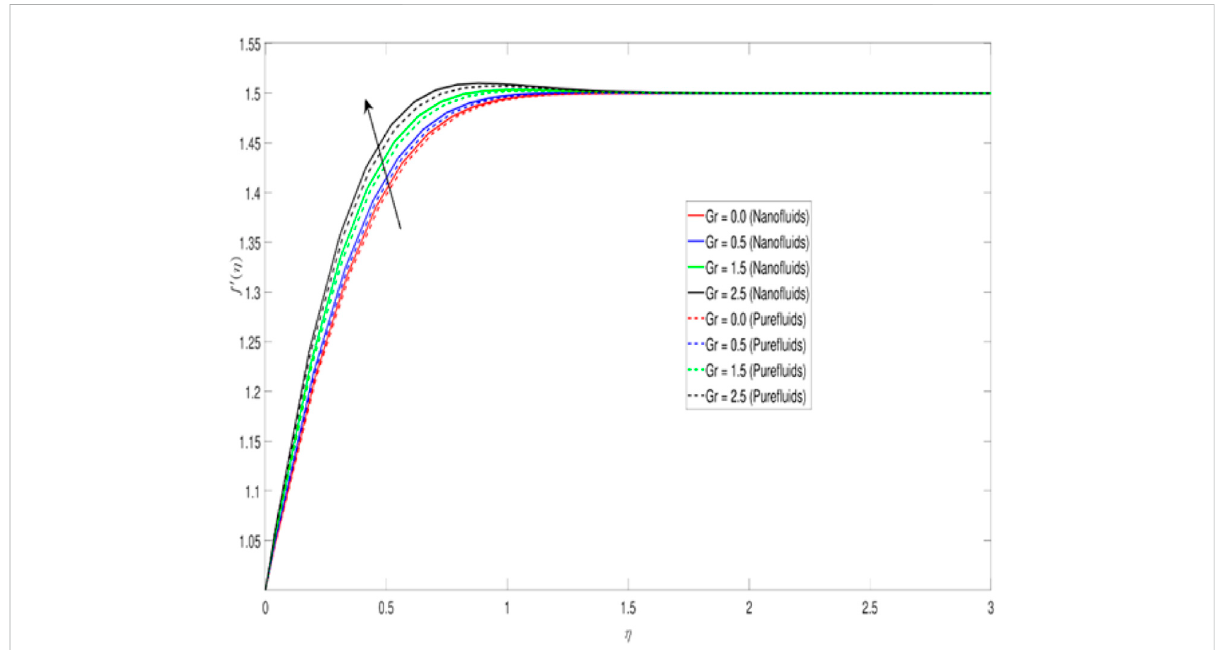
FIGURE 3 Velocity pro fi le in opposition to modi fi cations in the action of the buoyancy force.